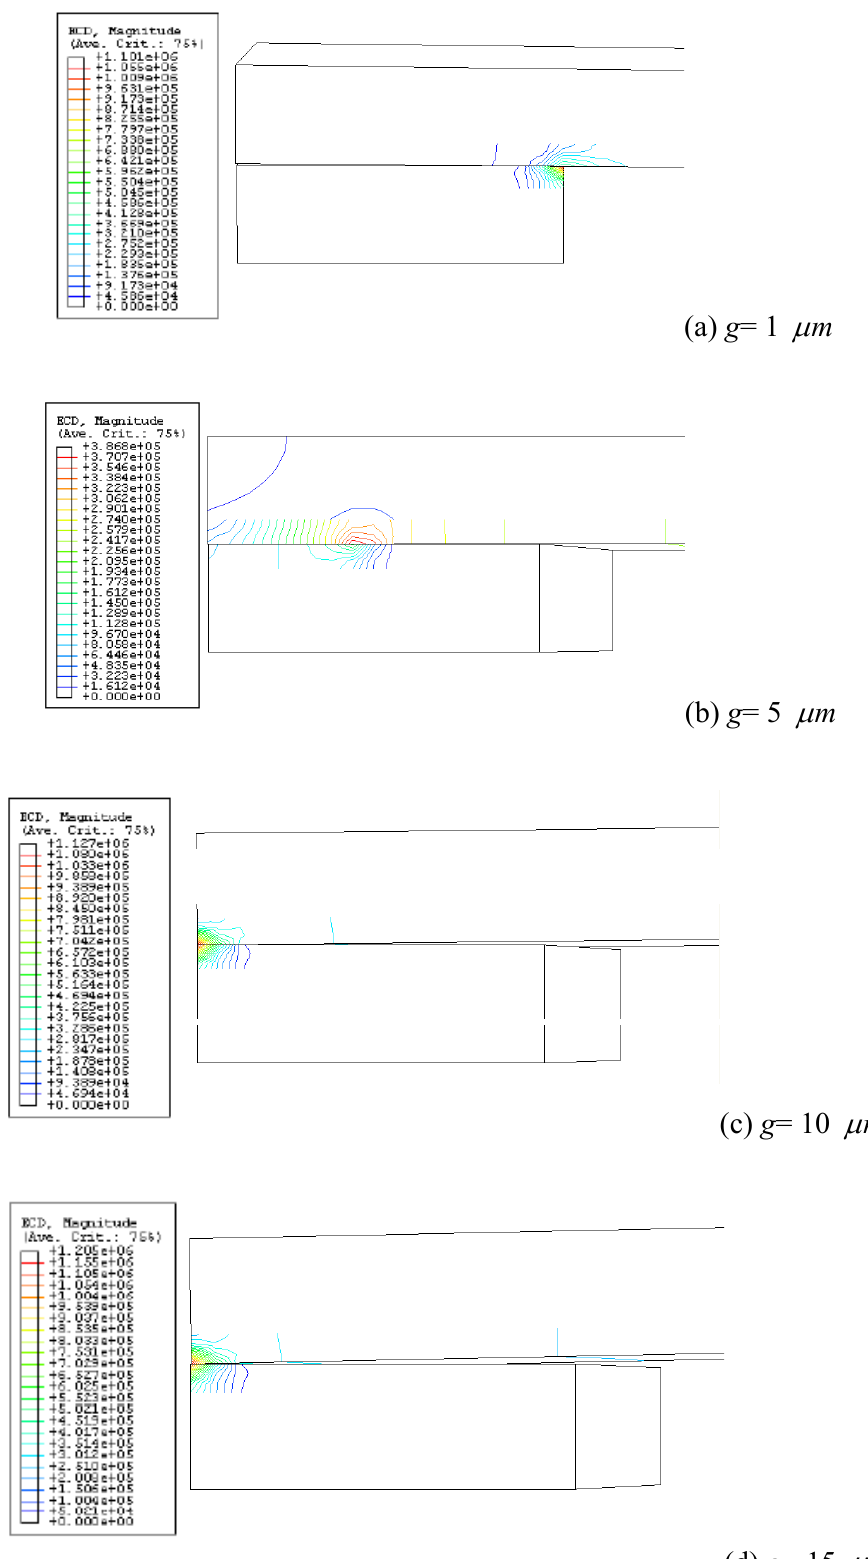
Figure 8. The electric current density distribution on the contact area for various contact